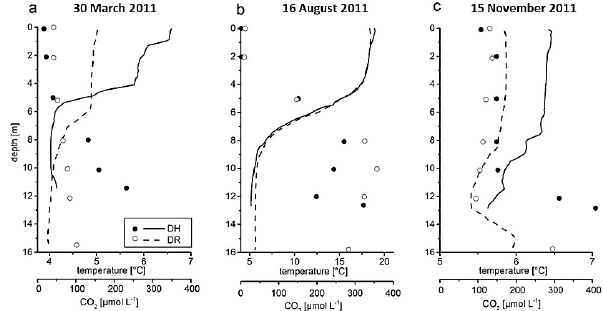
Fig. 5. Vertical profiles of temperature (lines) and CO 2 concentra- tions (dots) in both pre-dams in spring (a) , summer (b) and au- tumn (c) .